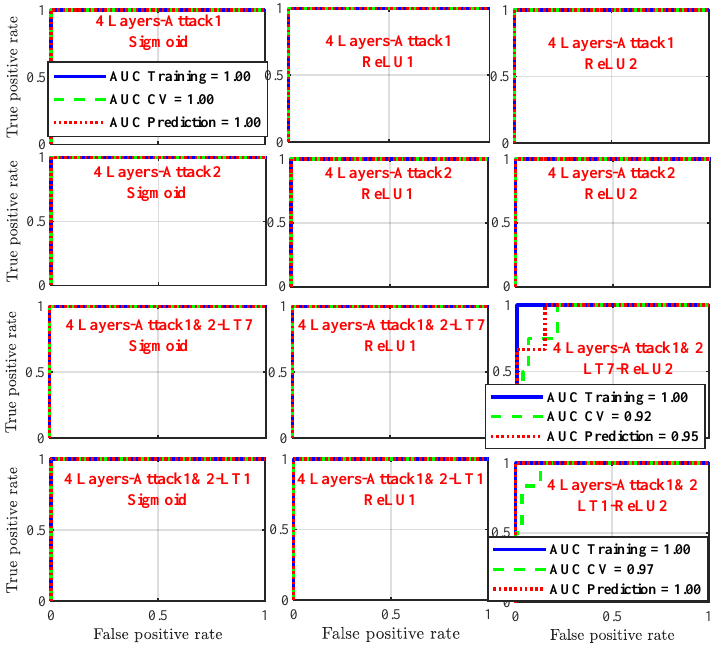
Figure 6. The ROC of various attack scenarios without any measurement noise, using the 4-layer DNN detection